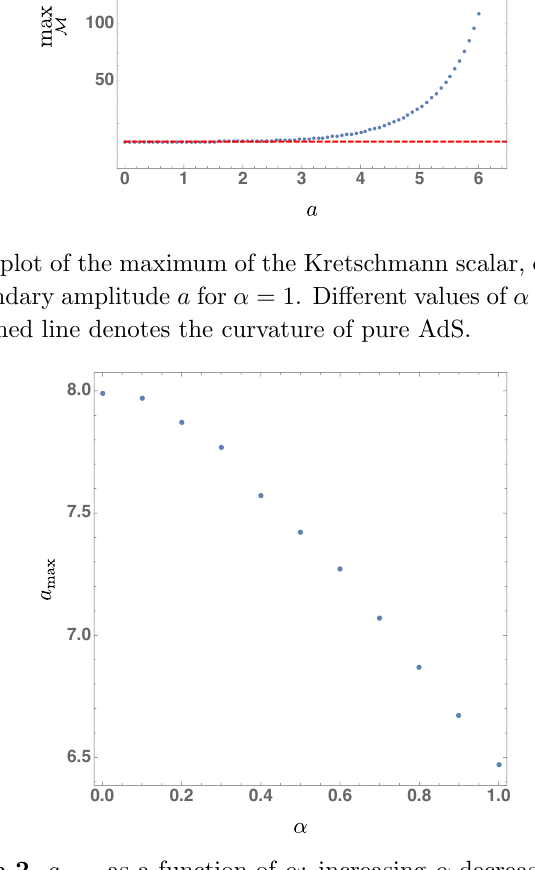
Figure 2 . a max as a function of (cid:11) : increasing (cid:11) decreases a max